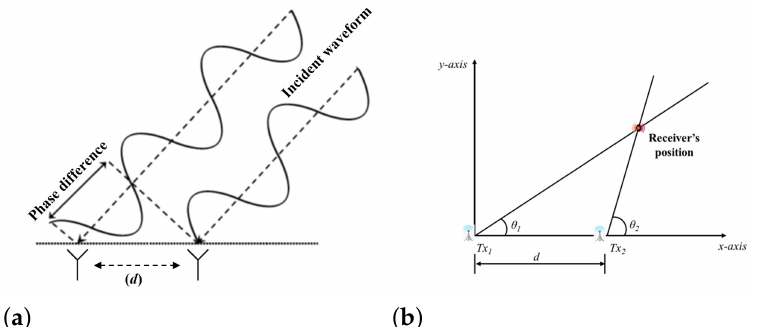
Figure 3. ( a ) Phase of Arrival (PoA) reproduced with permission from Zafari, A Survey of Indoor Localization Systems and Technologies; published by IEEE, 2019, ( b ) Angle of Arrival (AoA), re- produced with permission from Brena, Evolution of Indoor Positioning Technologies: A survey; published by Hindawi Limited,